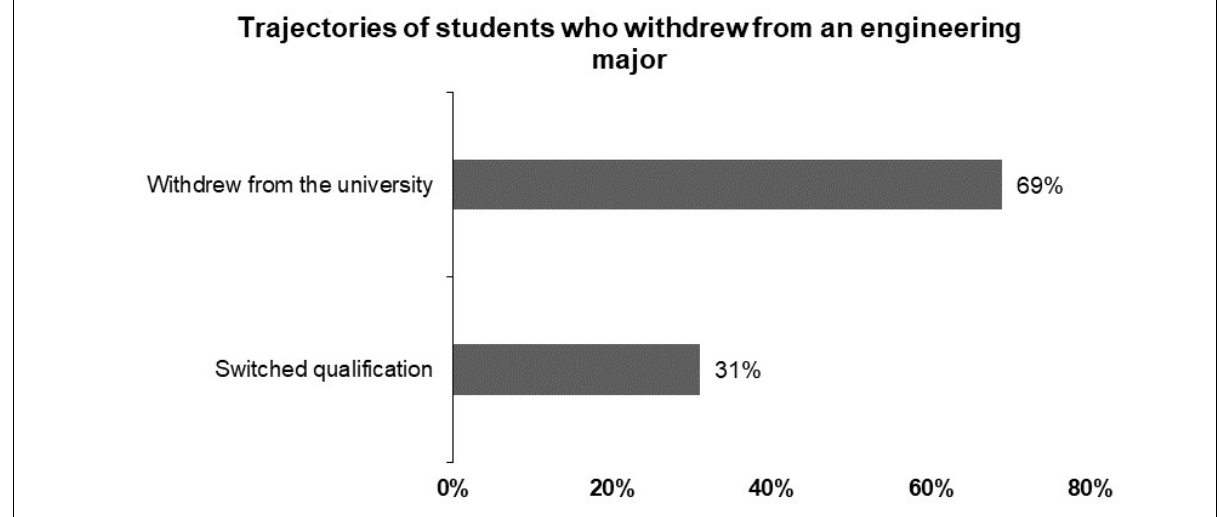
Figure 3: Trajectories of students who withdrew from the engineering major, n